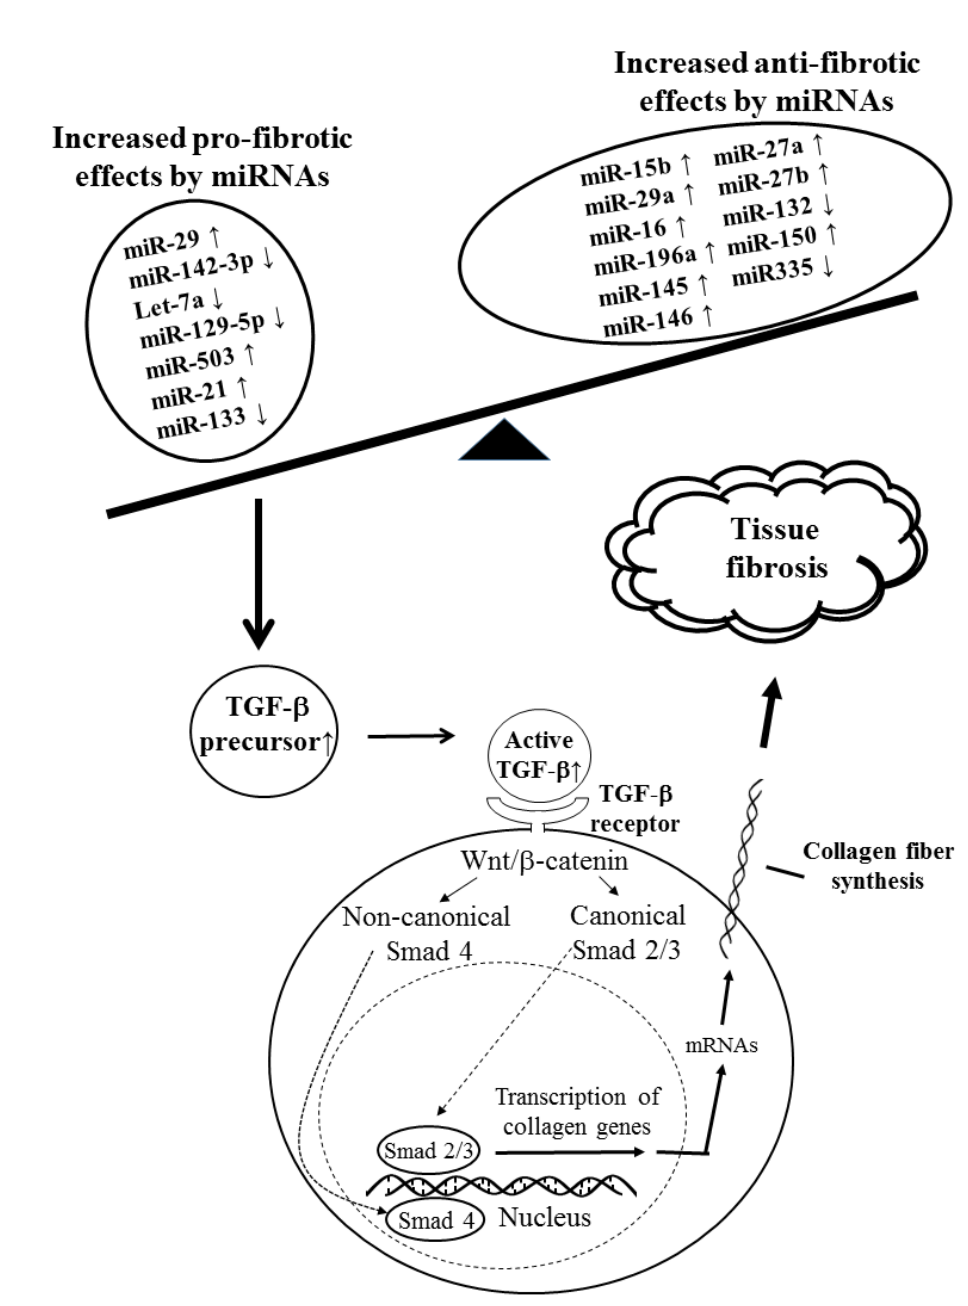
Figure 4. Imbalance between pro-fibrotic- and anti-fibrotic-related microRNAs skews the naïve helper T cell toward Th2 subpopulation. The TGF- β secreted from Th2 cell binds to TGF- β receptors on myofibroblasts. The binding transduces signals via both canonical (Smad 2 / 3) and non-canonical (Smad 4) Wnt / β -catenin pathways to transcribe the expression of collagen genes, COL-I, COL-II , and COL-IV . Finally, excessive collagen fiber synthesis and tissue fibrosis ensue. ↑ : upregulation, ↓ : downregulation.